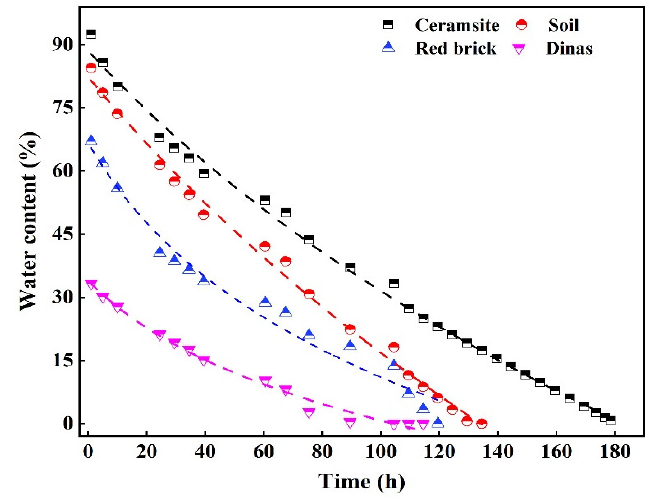
Figure 7. Water absorption and release capacity of different pore materials.